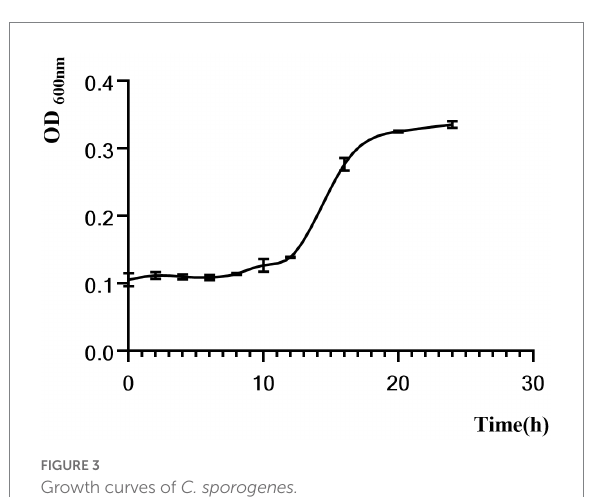
FIGURE 3 Growth curves of C.